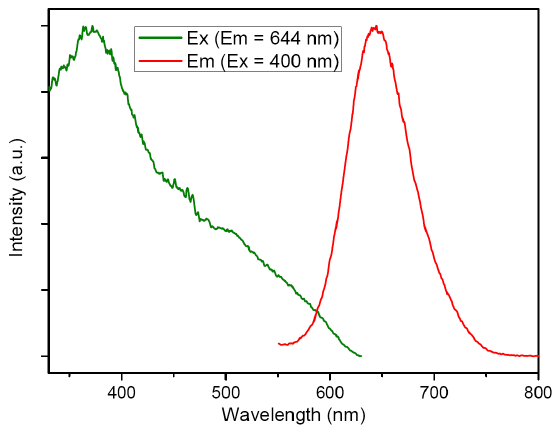
Figure 3. Excitation and emission spectra of 1 at ambient temperature.